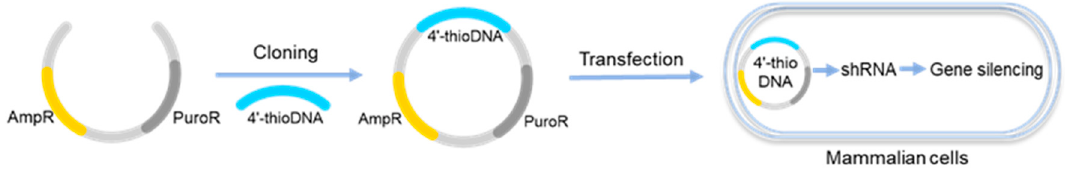
Figure 4. 4 (cid:48) -ThioDNA with gene-silencing activity in mammalian cells. Figure 4. 4 ′ -ThioDNA with gene-silencing activity in mammalian cells. Figure 4. 4 ′ -ThioDNA with gene-silencing activity in mammalian cells.